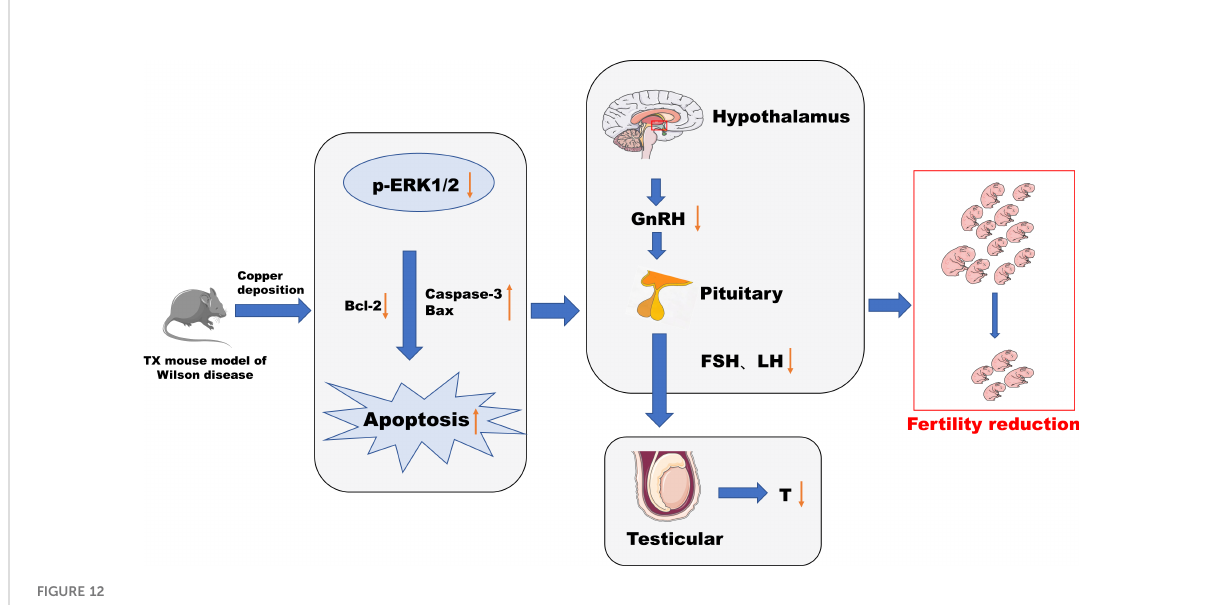
FIGURE 12 Conclusion